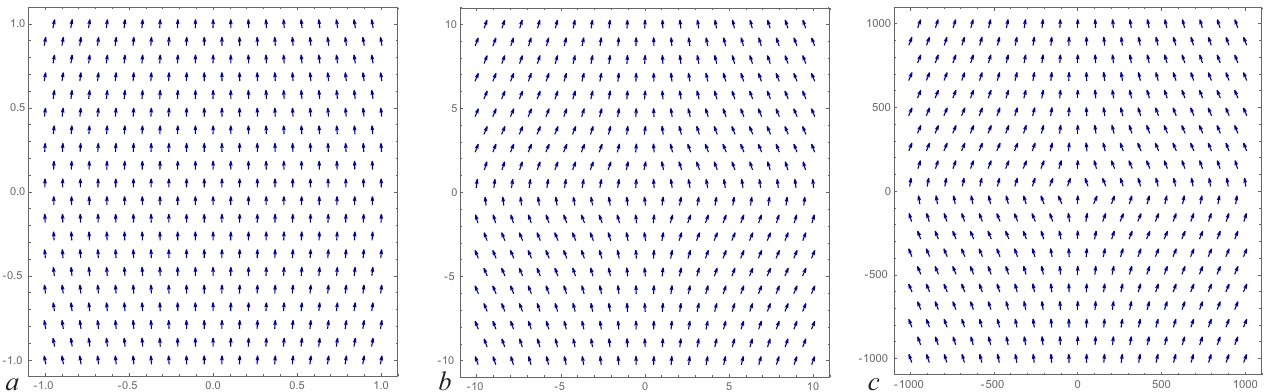
Figure 1. Spin distributions for the Bogomol’nyi–Prasad–Sommerfield solution for different ranges of coordinates: y 1 , z ∈ [ − 1,1 ] ( a ); y 1 , z ∈ [ − 10,10 ] ( b ); and y 1 , z ∈ [ − 1000,1000 ] ( c ). The plots are drawn numerically for e = 1 and l =